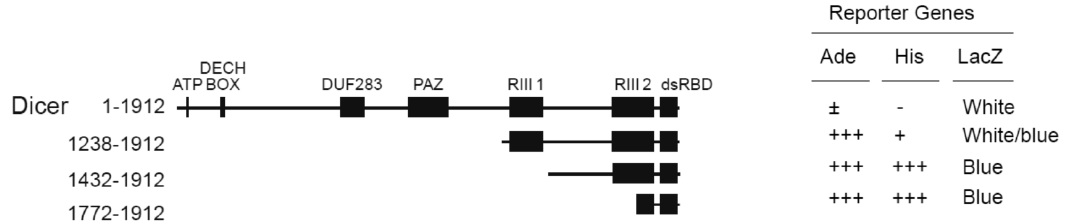
Figure 1. Tumor necrosis factor (TNF)-like weak inducer of apoptosis (TWEAK) interacts with the C-terminal dsRBD of human Dicer. The interaction between TWEAK and truncated forms of human Dicer was tested in a yeast two-hybrid system using strain PJ69-4A. The activity of the adenine ( Ade ), histidine ( His ) and β -galactosidase ( LacZ ) reporter genes was tested to validate the interaction. dsRBD, double-stranded RNA binding domain; DUF283, domain of unknown function 283; PAZ, Piwi-Argonaute-Zwille; RIII, ribonuclease III.